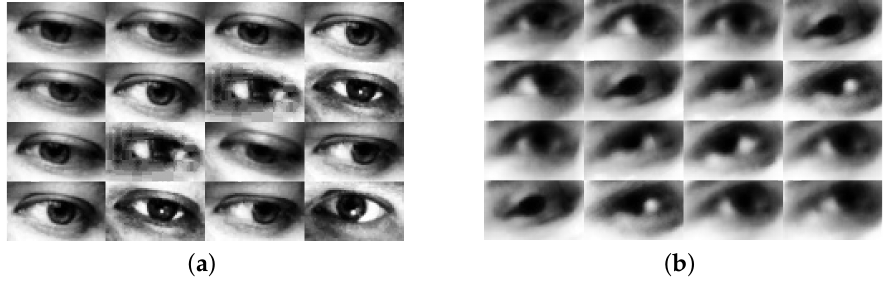
Figure 7. Sample images from MpiiGaze ( a ) and Eyediap ( b